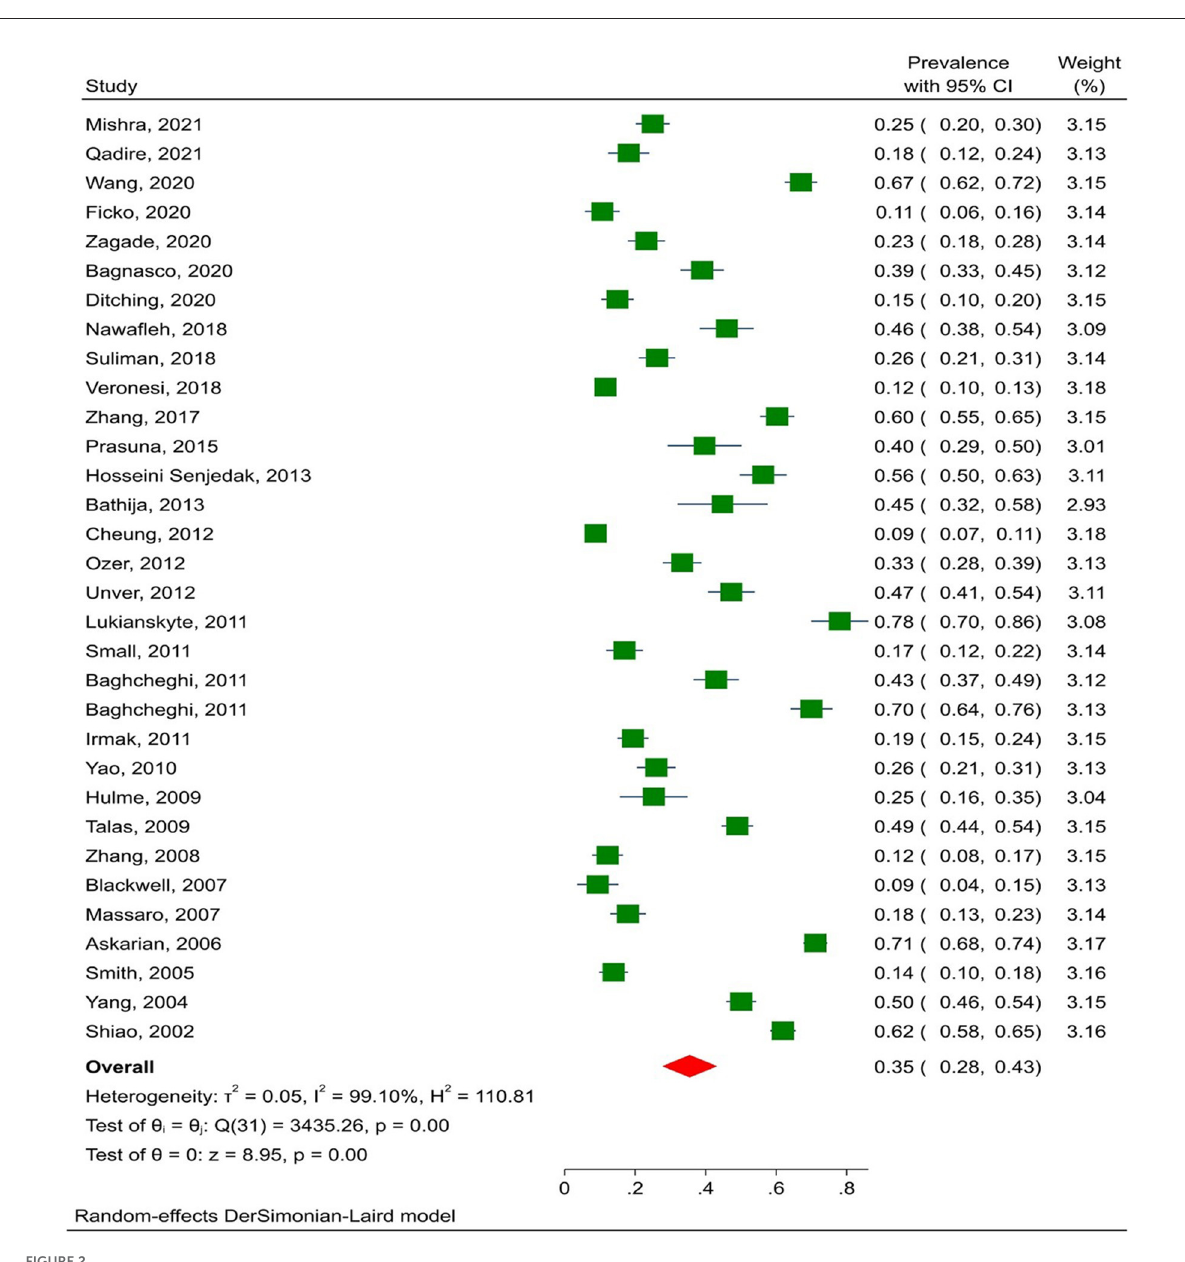
FIGURE2 The prevalence of NSI among nursing